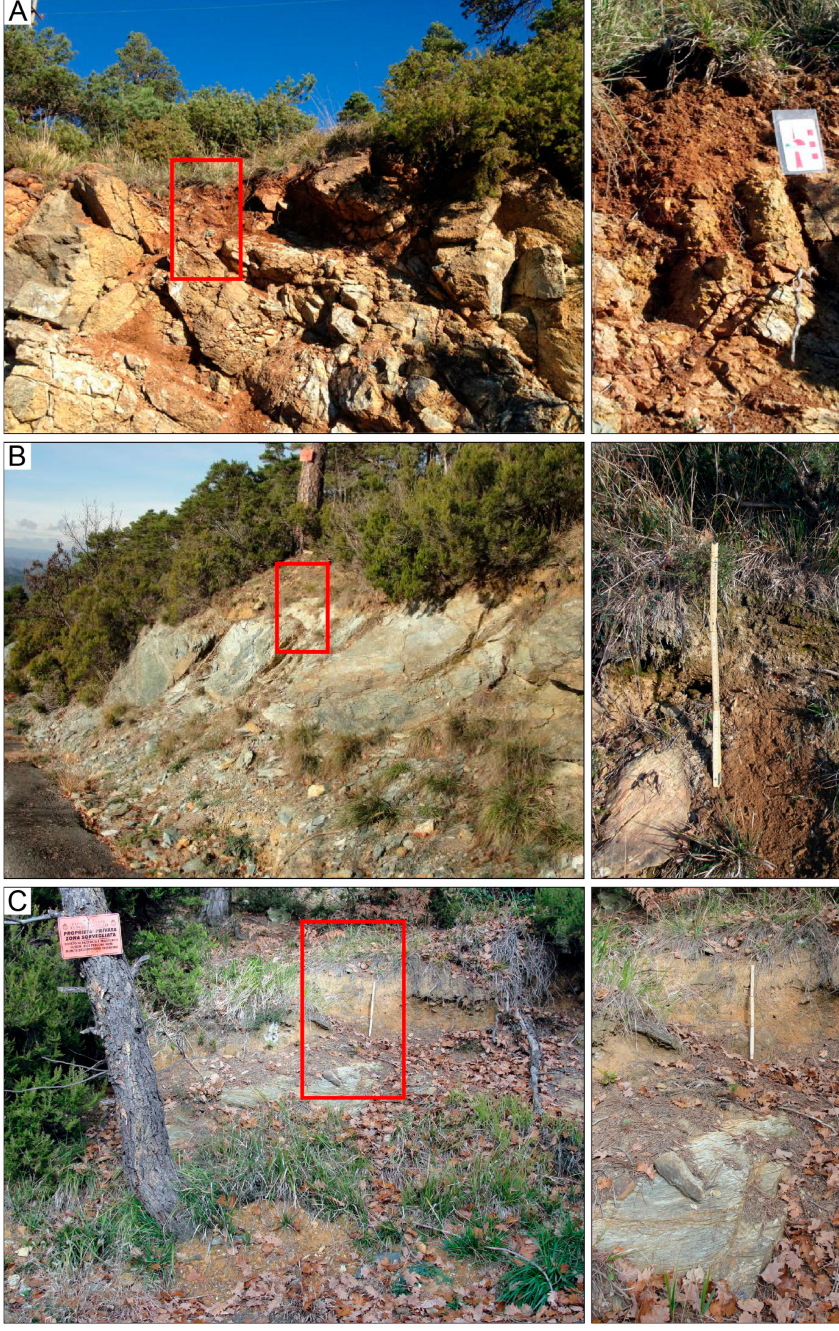
Figure 2. Representative photographs of the sampled sites. The red boxes indicates the sampled soil profiles shown on photographs to the right. ( A ) Soil profile on PSP bedrock (Site S7); ( B ) soil profile on MS bedrock (Site S2); ( C ) soil profile on FS bedrock (Site